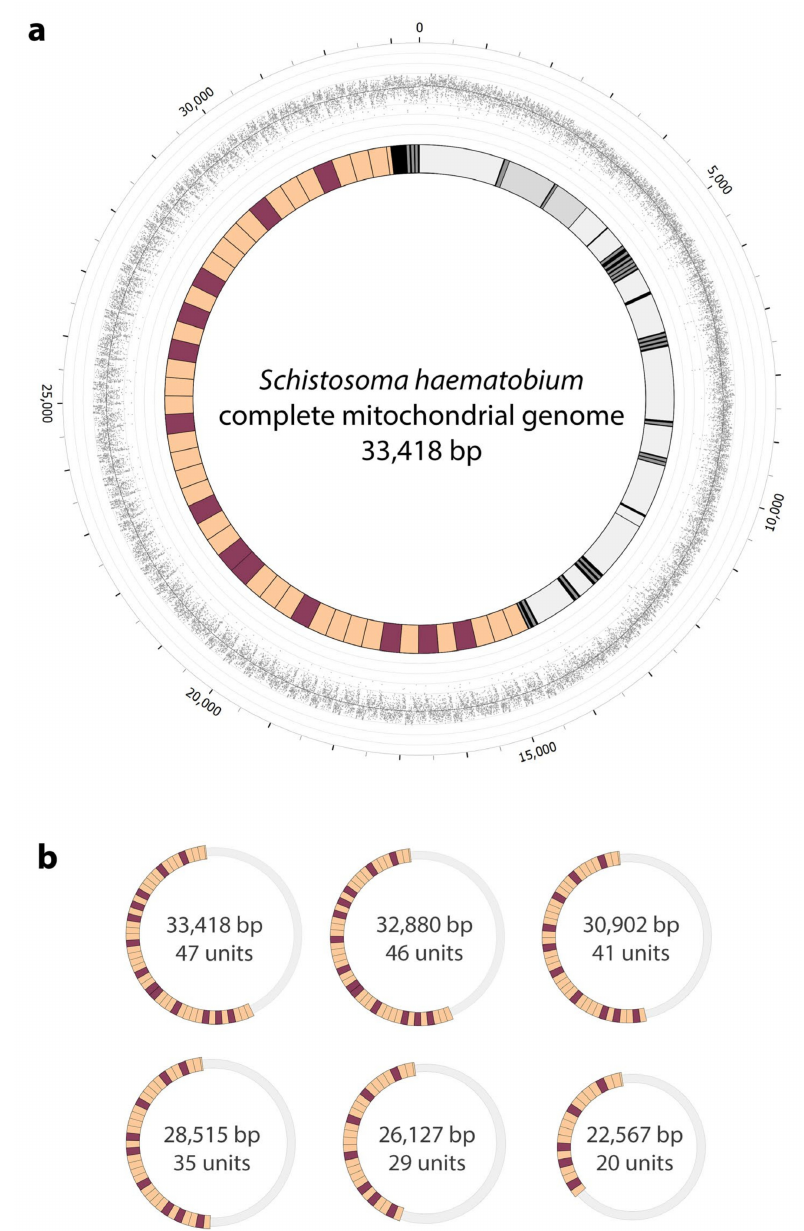
Figure 2. Complete mitochondrial (mt) genomes representing Schistosoma haematobium . ( a ) Schematic representation of the dominant, representative mt genome of S. haematobium (33,418 bp; inner circle), including the newly-identified tandem- repeat region (18,458 bp; units ShR1 and ShR2 in orange and purple, respectively). The 12 protein-coding genes, 2 rRNAs and 22 tRNAs (in shades of grey) are in accord with a published reference mt genome available in GenBank (accession no. DQ157222; [22]); short non-coding regions (<350 bp) are in black. The outer circle represents the coverage of long-reads (produced by Oxford Nanopore sequencing) across the genome. The graph shows the depth of nucleotides at each position (grey dots) and the smoothed average of depth across the genome (solid dark grey line). Circular axes represent every 100 reads mapped. Numbers on the outer circle represent positions on the genome in base pairs. ( b ) Schematic representation of all established mt genome lengths in S. haematobium supported by >150 Nanopore long-reads (cf. Figure 1). Numbers inside represent the length of the mt genome and the number of units in the tandem-repeat region. Sizes of the circles are proportional to genome